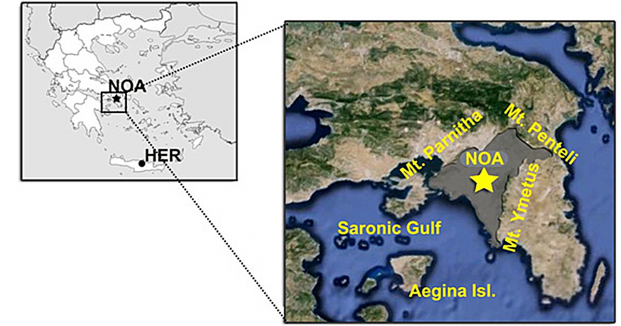
Figure 1. Map of the study area in Greece, including the Athens urban station (NOA) and the non-urban reference station (HER) at Heraklion airport, Crete. The grey surface in the colored map rep- resents the boundary of the Greater Athens Area (GAA).